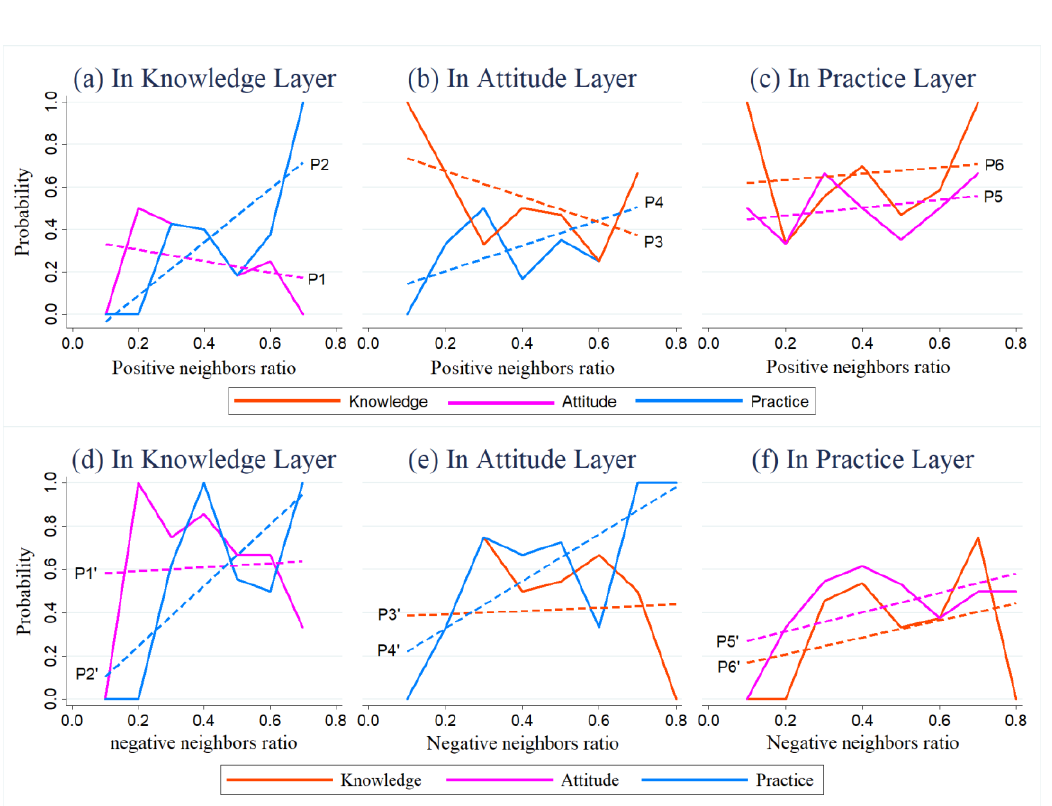
Figure 8d–f, respectively, represent the correlations between 1 − q knowledge, attitude, and practice layers.